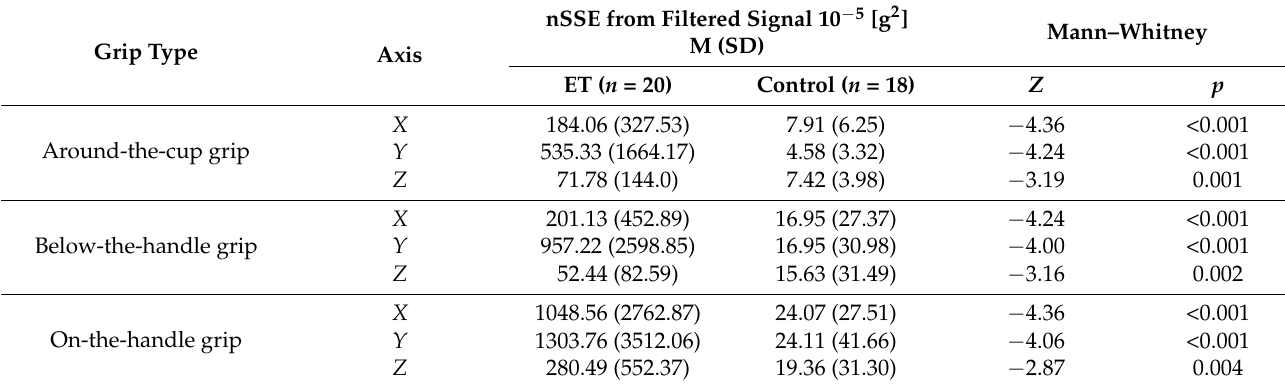
Table 1. Comparison of Acceleration in the Time-Domain